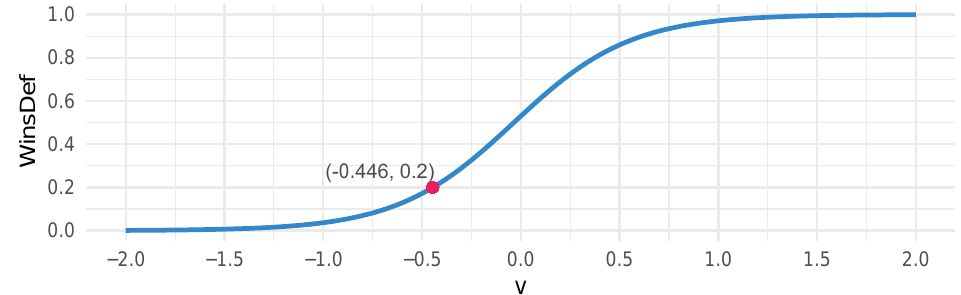
Figure 10. Assessment of the adversary’s intentions. The plot shows the Allied troops’ deficient capability to reject attack (20%), with a defender’s Advantage Factor v = − 0.446. Therefore, P Germantroops < 80%, matching with the real intention of the German Strategy on 27 April